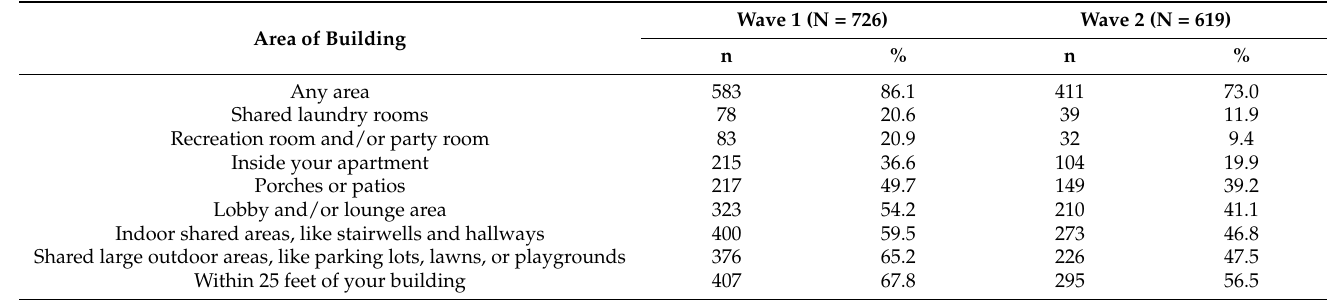
Figure 1. Proportion of respondents reporting smoke incursions every day or a few times a week, Wave 1 vs. Wave 2. Table 3. Proportion of residents who reported smelling tobacco smoke in the past 7 days in living and common areas.